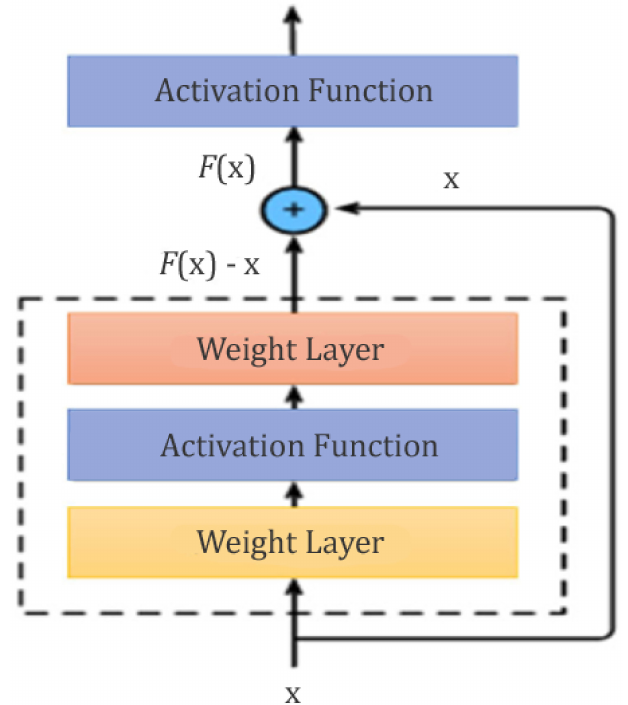
Figure 11. ResNet